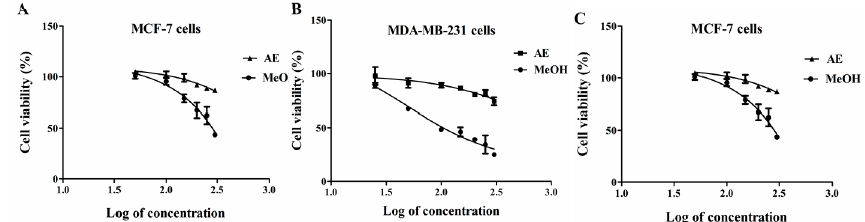
Figure 1. Concentration-dependent cytotoxicity of F. umbellata aqueous (AE) and methanolic extracts (MeOH) in breast cancer and non-tumoral cell lines. MCF-7 ( A ); MDA-MB-231 ( B ); and NIH-3T3 ( C ) cells were incubated with increasing concentrations (50–300 µ g/mL) of extracts for 24 h and cell viability was evaluated by Alamar blue (resazurin) assay. The results are expressed in percentage as the mean ± SEM.